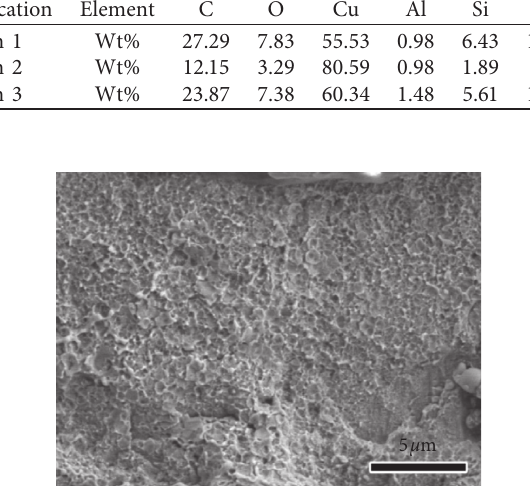
Figure 11: Micrographs of fracture surface of the pin of the resistor